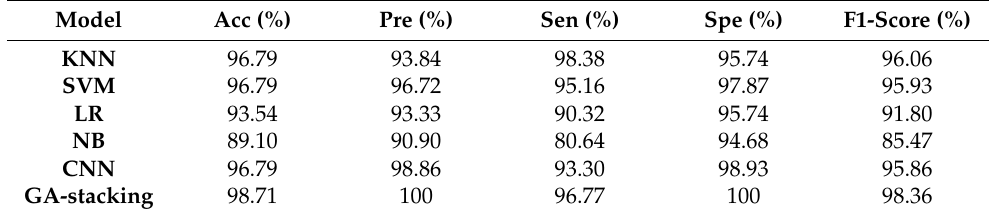
Table 2. Performance of different modules on the UCI data set.